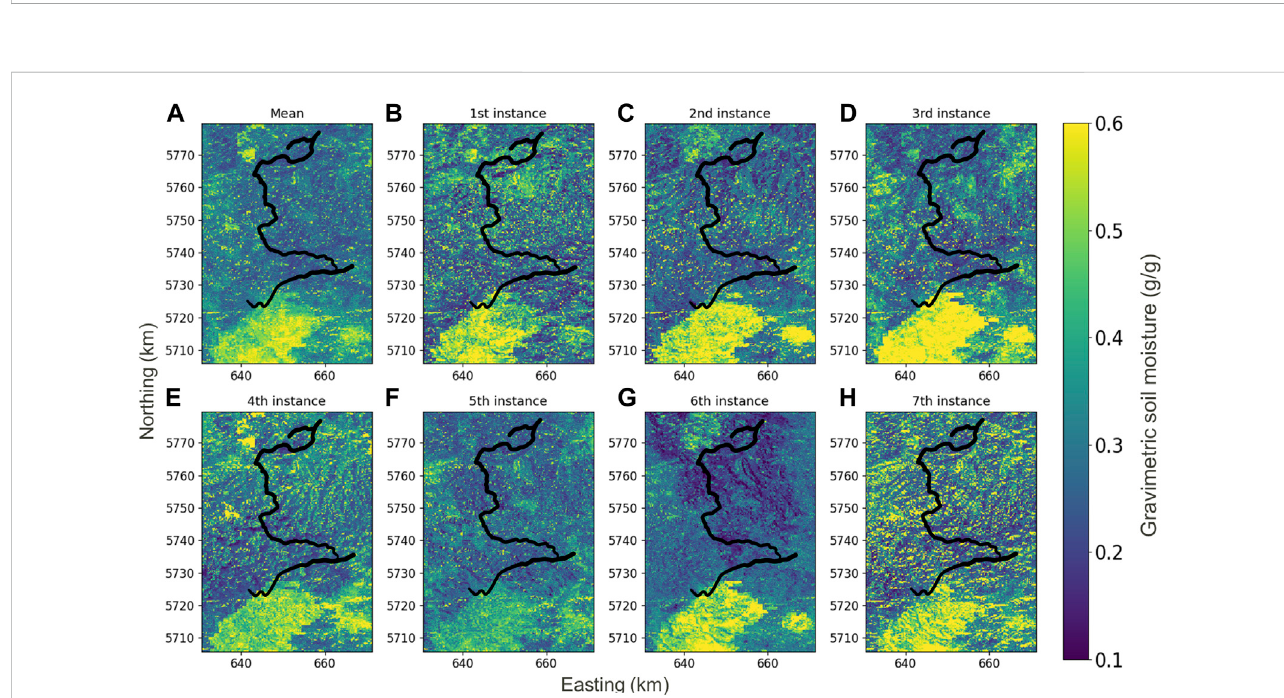
FIGURE 9 Soil moisture maps obtained from random forests through a Monte Carlo approach. The mean soil moisture map after 1,000 iterations (A) followed by the fi rst instances of the Monte Carlo simulation (B – H) are displayed.